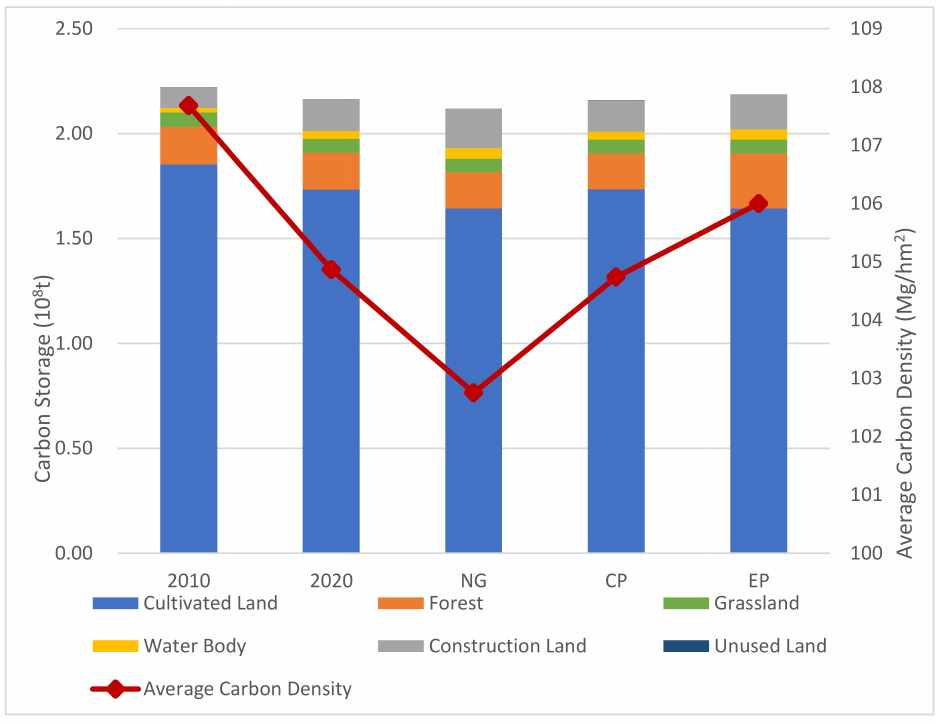
Figure 4. Carbon storage and average density in 2010, 2020, and under three scenarios in 2030.